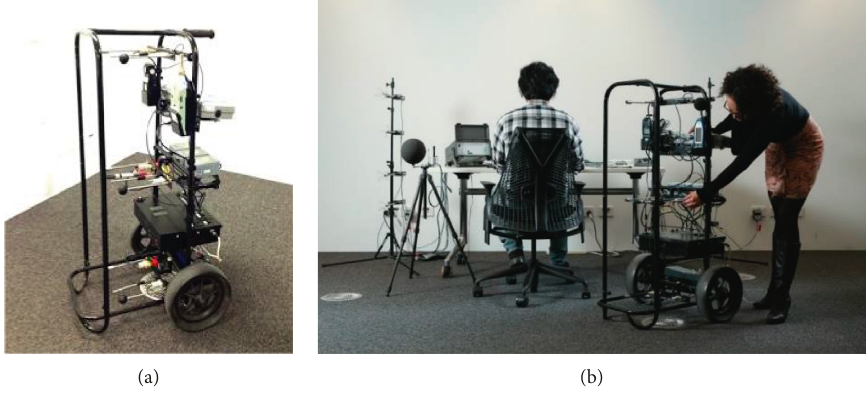
Figure 2: Indoor environment evaluation vehicle, BOSSA